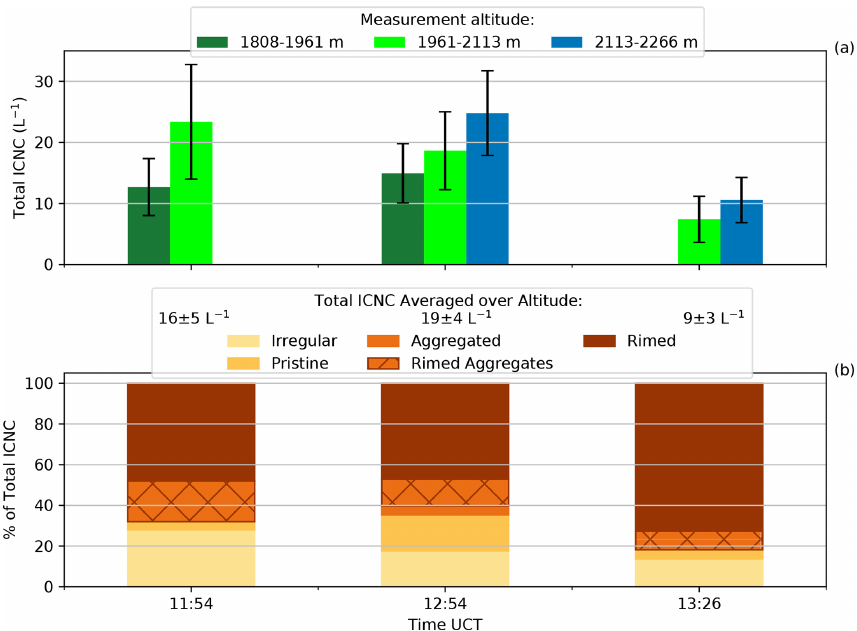
Figure 3. HoloGondel measurements on 7 March 2019. (a) Total ICNC and measurement uncertainty (black error bars) of each gondola run at each altitude. No measurements were taken at 11:54UTC between 2113–2266m and at 13:26UTC between 1808–1961m. (b) Irregular, pristine, aggregated, rimed and rimed aggregate ice particles as the percentage of total ICNC averaged over the altitudes of each gondola run are shown. The median temperature for each of the rides at the respective height, 1808–1961, 1961–2113 and 2113–2266m, corresponds to − 1, − 1 . 5 and − 2 . 5 ◦ C,